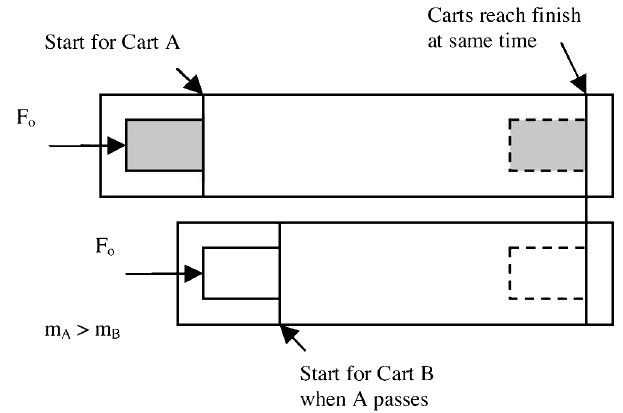
FIG. 2. Second experimental setup used for post-test